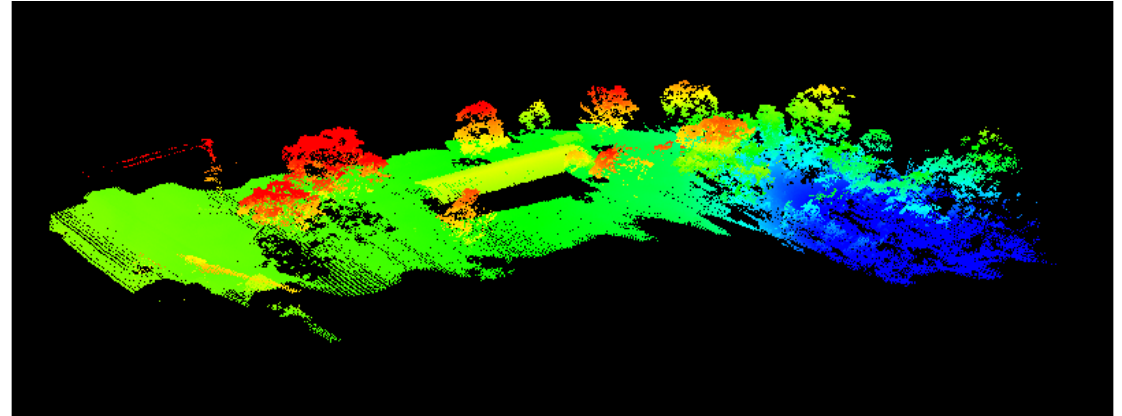
Figure 7. An example point cloud produced by the SfM trajectory determination algorithm. This particular point cloud has an average point density of 40 points per m 2 and covers 4,877 m 2 .